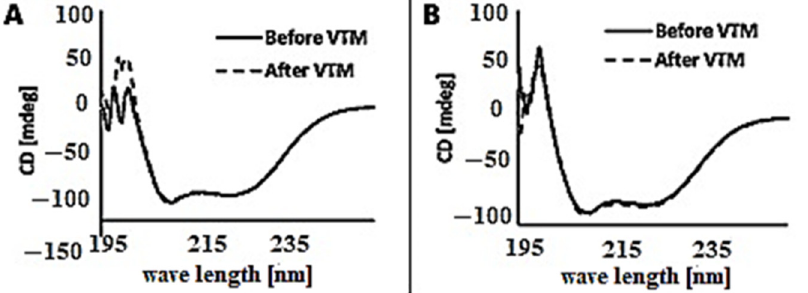
Figure 2. Circular dichroism measurements of ( A ) ZHER2:41071 and ( B ) ZHER:V2 before (black line) and after (dotted line) variable temperature measurements (VTM). The curves indicate alpha-helical conformation and reversibility after heat treatment.